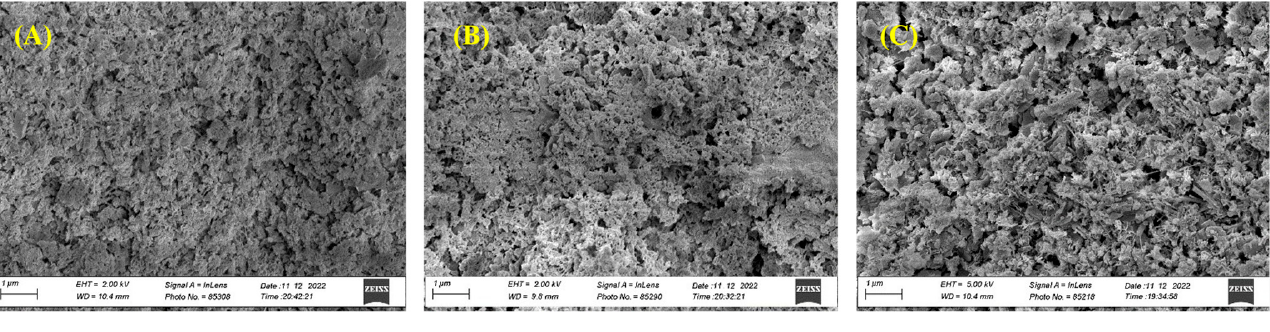
Figure 8. SEM images of HSFCM after treatment at 20 ◦ C ( A ), 100 ◦ C ( B ) and 400 ◦ C ( C ). The surface of the HSFCM specimen without high temperature treatment is more uniform and flat; the number of pores and micro-cracks is less; the hydration products grow freely; there are Ca(OH) 2 , ettringite crystals and C-S-H gels, etc.; the contact between particles is close; the bonding degree is higher; and the microstructure is good. When the temperature is 100 ◦ C, the surface is slightly convex; the fold becomes rough; the size and number of pores increase, but no obvious crack development has occurred; and the degree of bonding of the gel becomes low. At 400 ◦ C, a large number of irregular crystals and whiskers appear; the bonding substance between the crystals is reduced; the specimen surface becomes uneven; the honeycomb micro-pores increase; the pore structure increases; and the micro-cracks develop through each other, which is consistent with the results of CT scanning and XRD